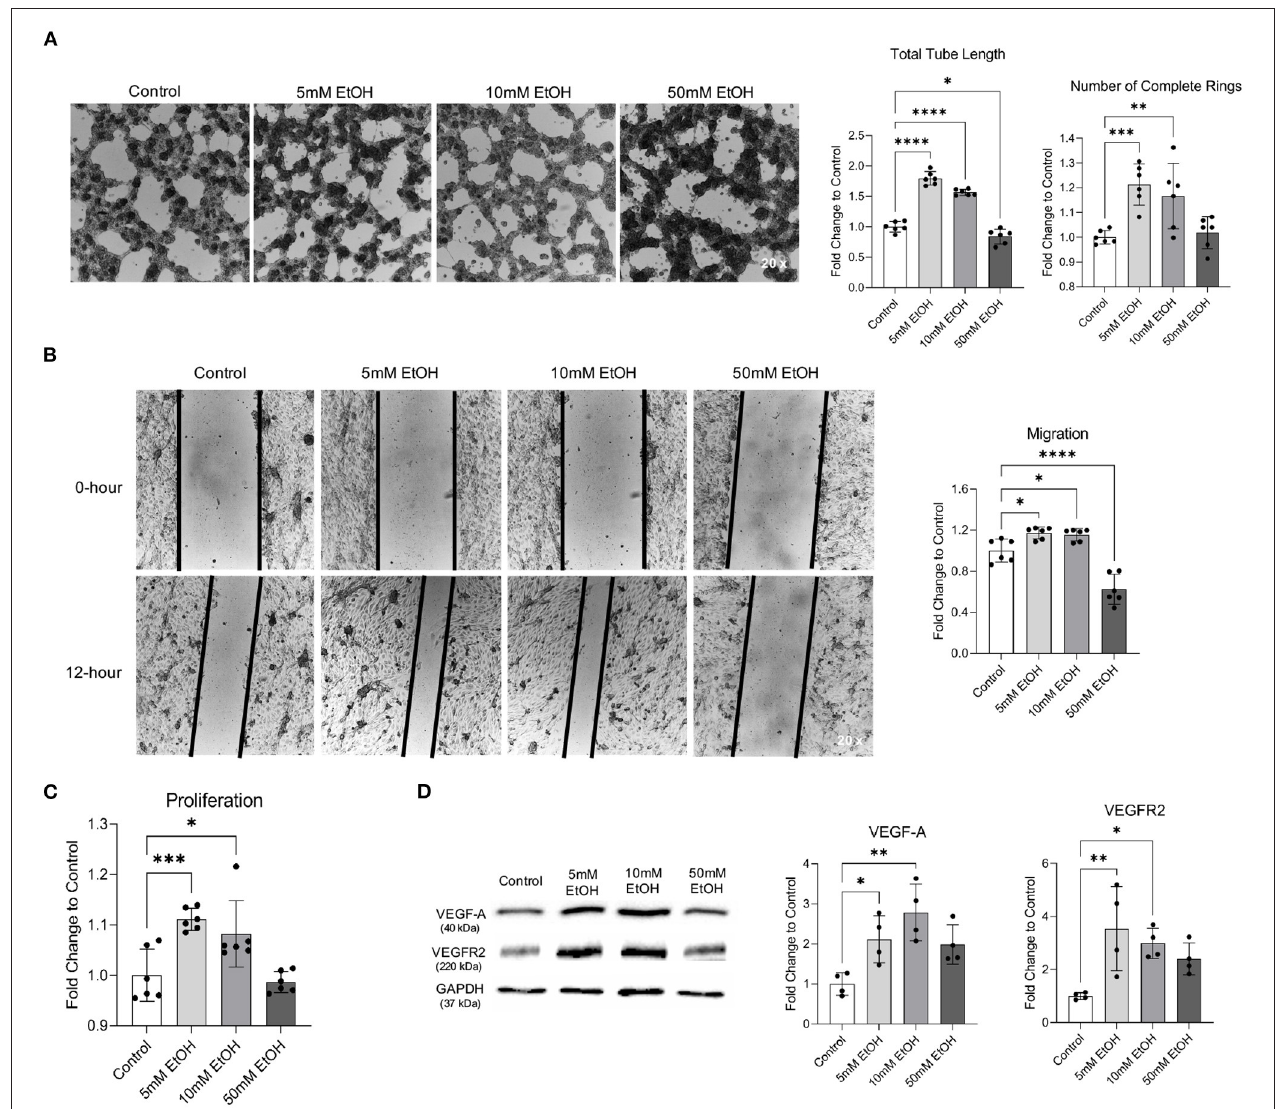
FIGURE 2 | Effect of chronic alcohol exposure on tube formation, migration, proliferation, and expression of VEGF-A and VEGFR2 in MBMVECs. (A) Representative images of tube formation (left). Values are means ± SD (right, n = 6). (B) Representative images (left) of migration. Values are means ± SD (right, n = 6). (C) Values are means ± SD ( n = 6) for proliferation. (D) Representative Western blots of VEGF-A and VEGFR2 (left). Values are means ± SD (right, n = 4). * P < 0.05, ** P < 0.005, *** P < 0.0005, **** P < 0.0001 vs. Control. Analyzed using one-way ANOVA with Dunnett’s post-hoc